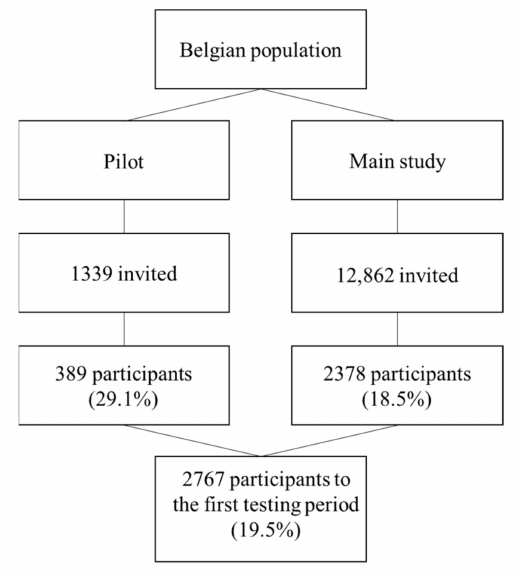
Figure 2. Number of invited people, participation rate, and net sample obtained. An overview of the characteristics of the study population and their vaccination status is presented in Table 2. In summary, 54.9% of the participants were women, 46.4% were between 18 and 49 years old, 42.7% had at most a high school diploma, and 8.1% were a healthcare worker. As a result of the Belgian vaccination strategy at the time of the study, which focused on priority groups, vaccinated people were relatively older and included a higher share of women, health care workers, people with at least one chronic disease, and people vaccinated against influenza. As compared to the vaccinated, the unvaccinated were younger, more often men and smokers, as well as people who reported to have tested positive for COVID-19. Table 2. Description of the study